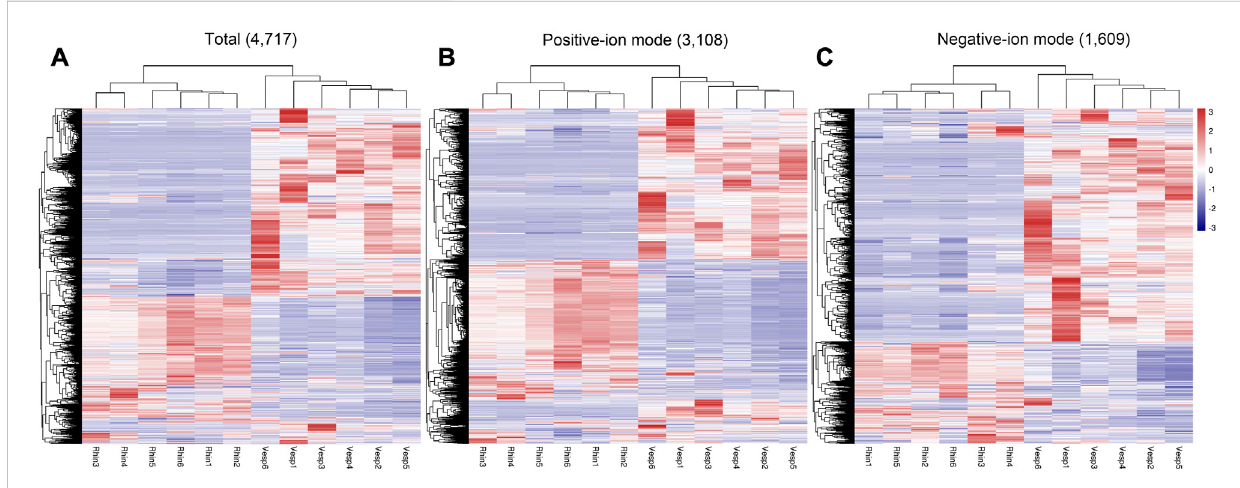
FIGURE 2 Heatmapsofthe4,717annotatedmetabolitesidenti fi edinthecochleaof R.sinicus and V.sinensis . (A) Total ions, (B) Positiveion mode, (C) Negative ion mode. Rhin and Vesp stand R. sinicus and V. sinensis , respectively, as also used elsewhere in this paper.